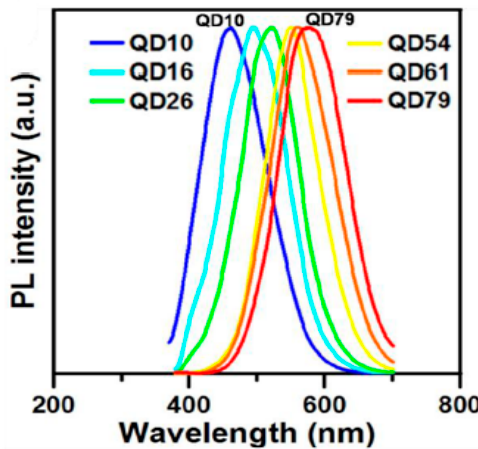
Figure 4. Normalized PL spectra ( λ ex = 350 nm) of QD10, QD16, QD26, QD54, QD61 and QD79. Reprinted (adapted) with permission from [54]. Copyright 2021 American Chemical Society.